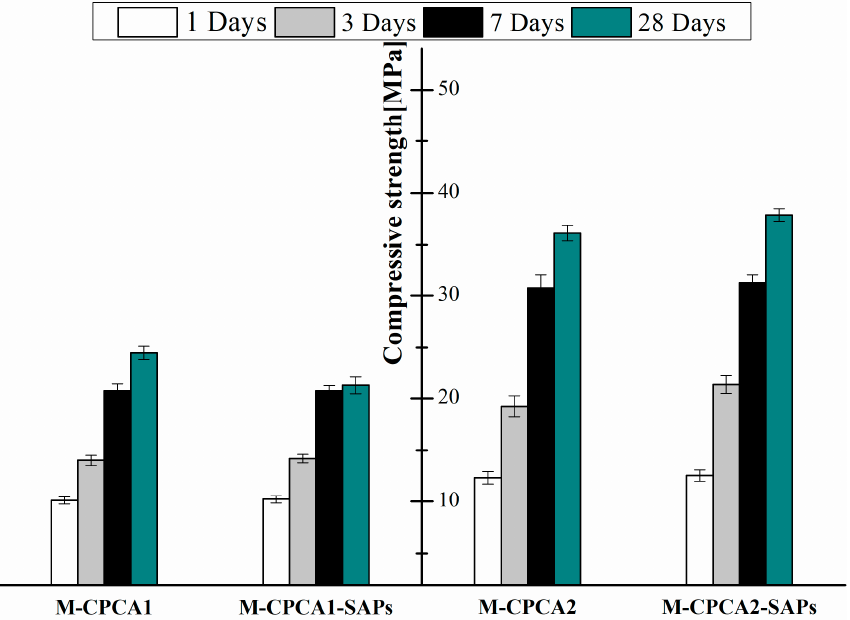
Figure 4. Compressive strength of mortar made by cement paste containing accelerator with or without SAPs (The error bar is the standard deviation of the compressive strength).